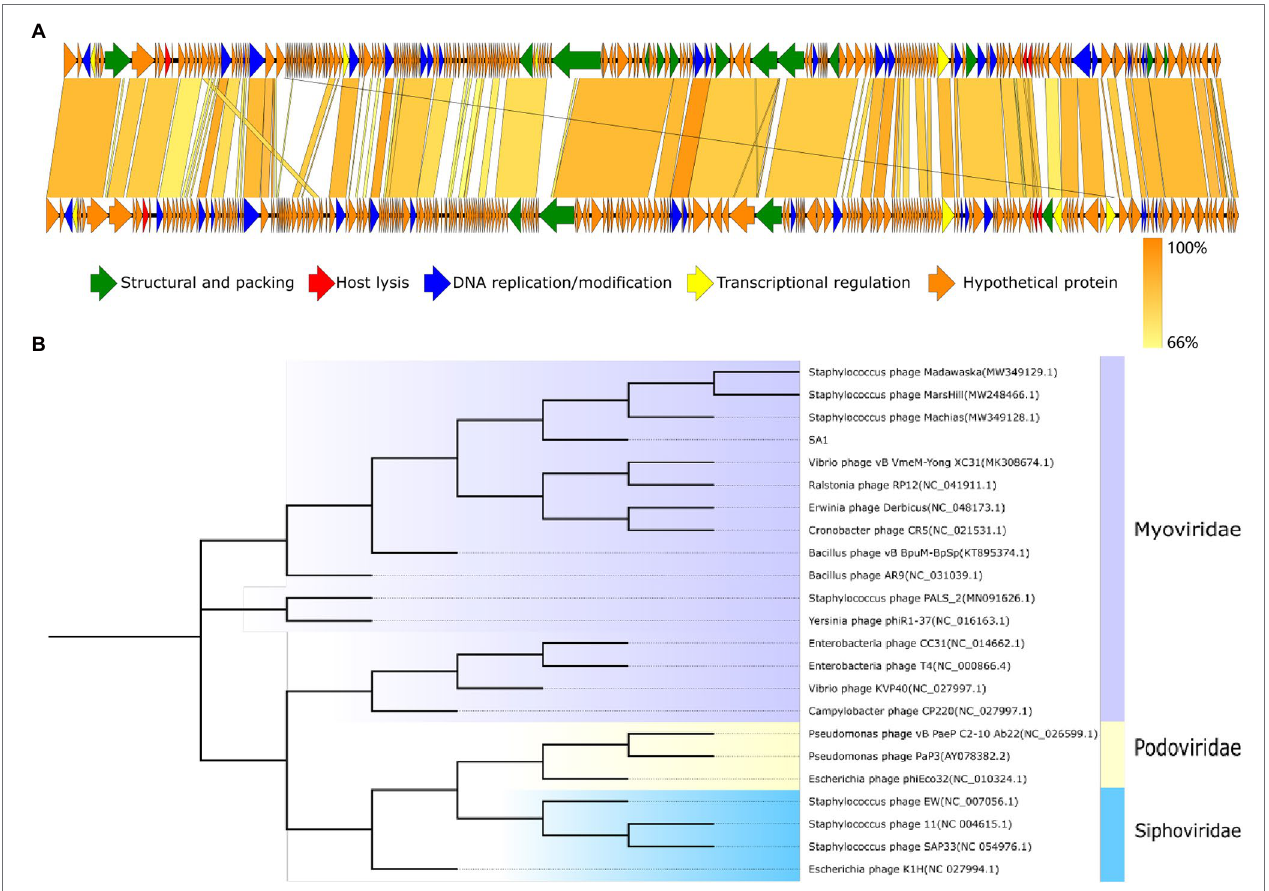
FIGURE 5 | Evolutionary and comparative genome analysis of phage SA1. (A) Genome comparison between phage SA1(above) and PALS2(below). (B) Phylogenetic tree of phage SA1. The amino acid sequence of conserved protein terminase large subunit (ORF138) was aligned with the maximum likelihood method based on the JTT matrix-based model, with a bootstrap assessment based on 1,000 replicates. Genes with different functions in genome comparison and different subfamilies in the evolutionary tree are marked with different